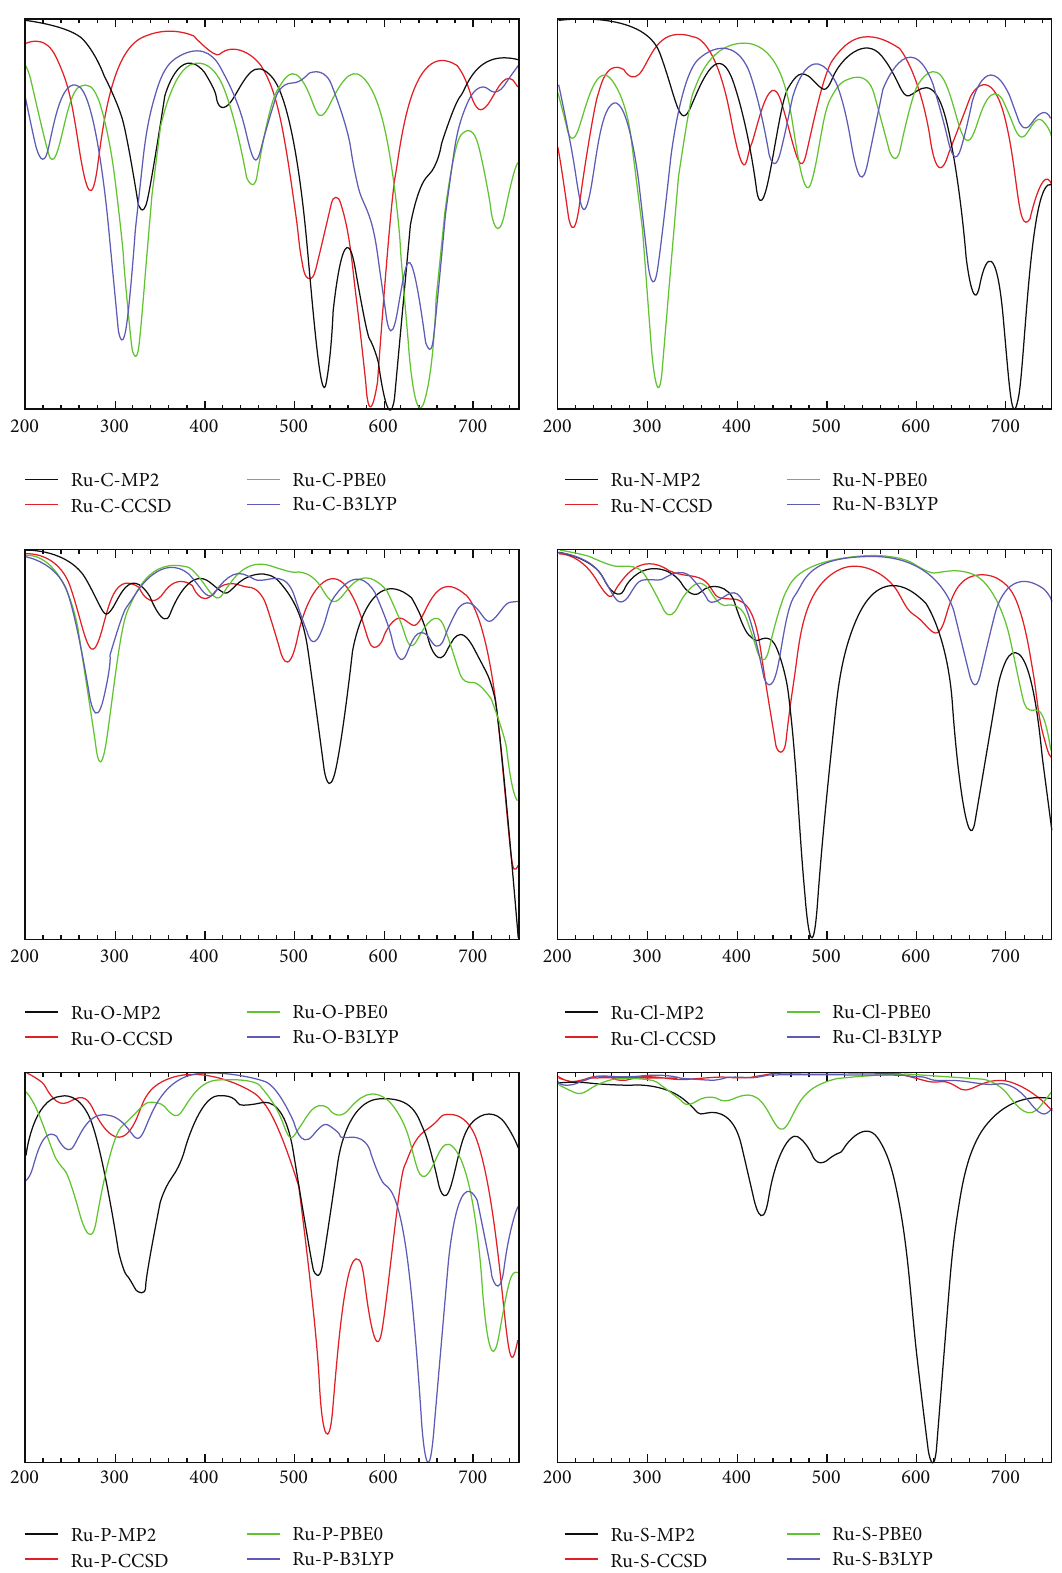
Figure 3: The IR vibrations of the six models computed using MP2 (black), CCSD (red), PBE (green), and B3LYP